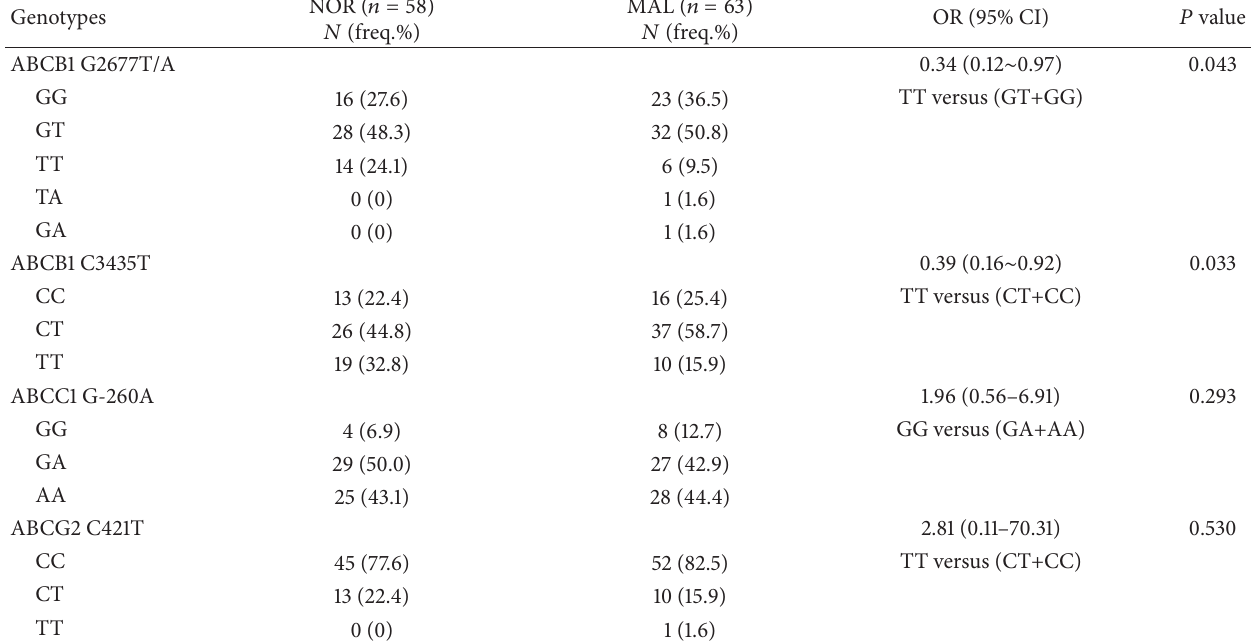
Table 3: Genotypic frequency in European